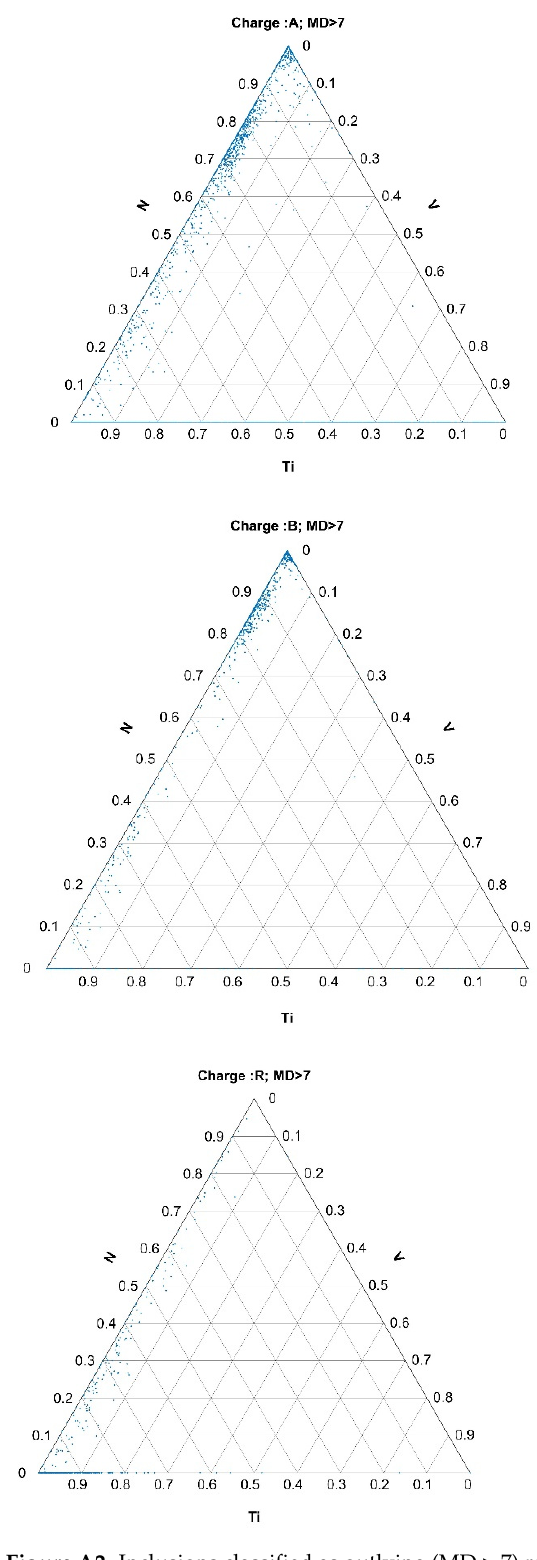
Figure A2. Inclusions classified as outlying (MD > 7) represented in a ternary diagram of Ti, V, and N for charges A, B, and R.